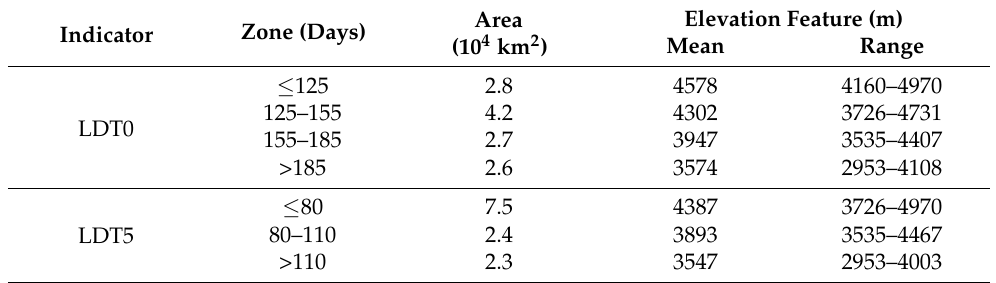
Table 4. The area and elevation features of the zones in the